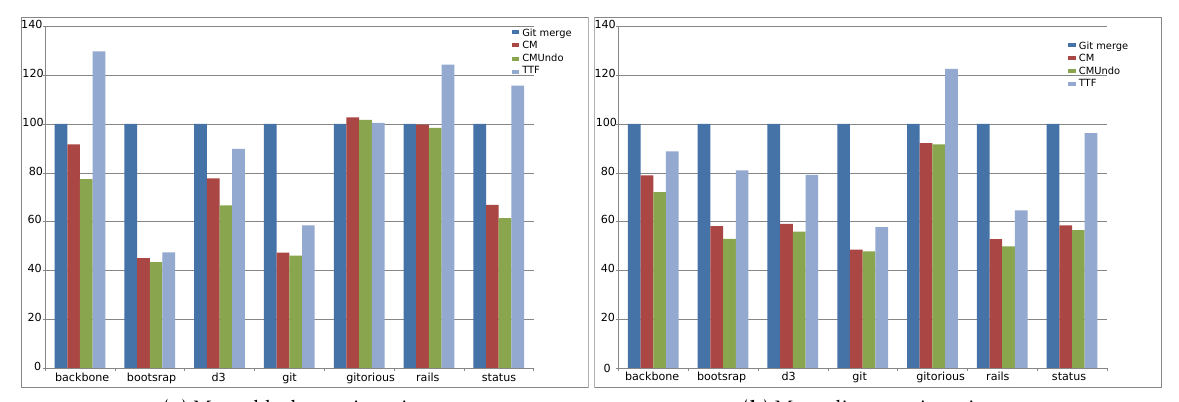
Figure 16. Merge blocks and merge lines